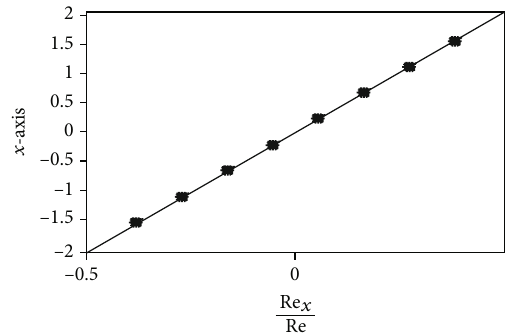
Figure 11: The ratio local to global Reynolds number for all the